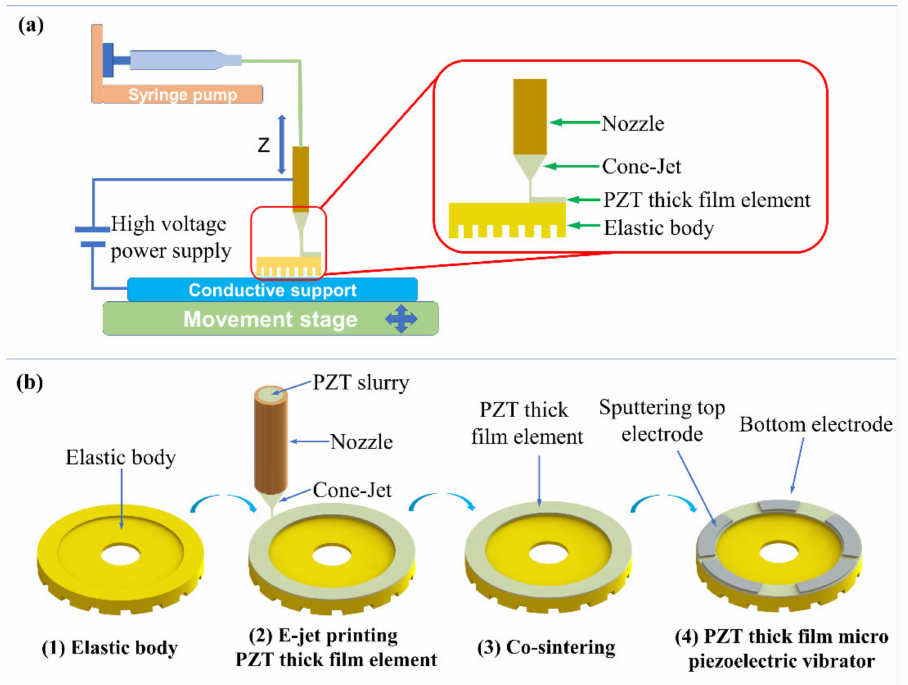
Figure 2. ( a ) Schematic diagram of E-Jet printing equipment and ( b ) preparation of the PZT thick film micro